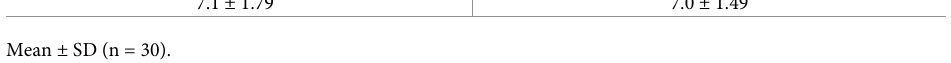
Table 2. Bacterial cell length ( μ m) of the original (OG) and mutant (MT) strains. OG MT 7.1 ± 1.79 7.0 ± 1.49 Mean ± SD (n =